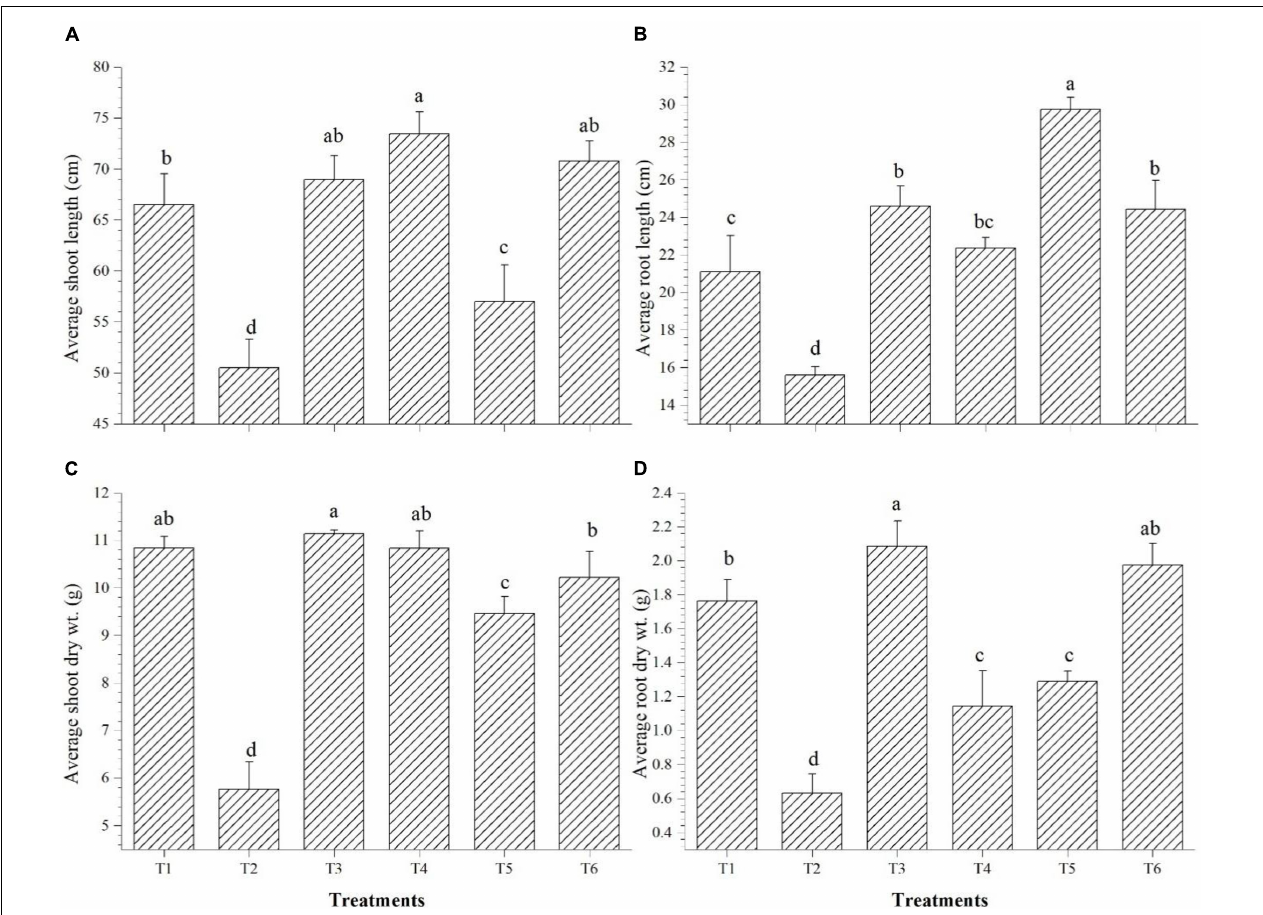
FIGURE 8 | Effect of bacterial endophytes on the growth and biomass accumulation of tomato plants under elevated salinity (150 mM NaCl). (A) Average shoot length, (B) average root length, (C) average shoot dry weight, and (D) average root dry weight. T1, absolute control; T2, saline control; T3, BTL5; T4, GTR8; T5, GTR11; and T6,